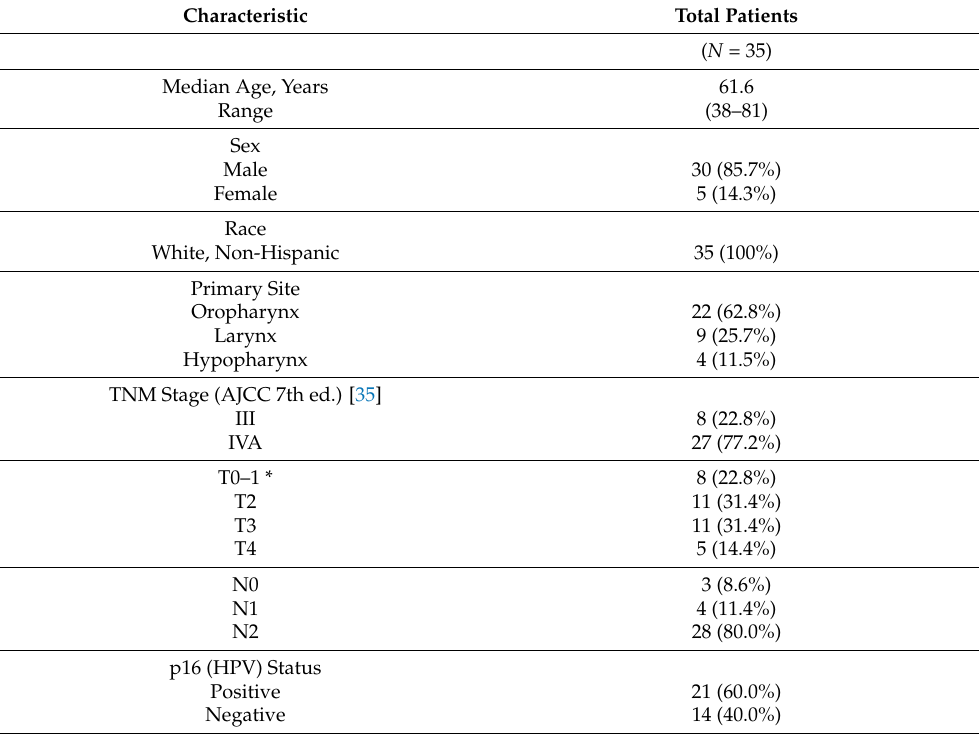
Table 1. Patient and tumor characteristics from clinical trial adding pembrolizumab to chemoradio- therapy